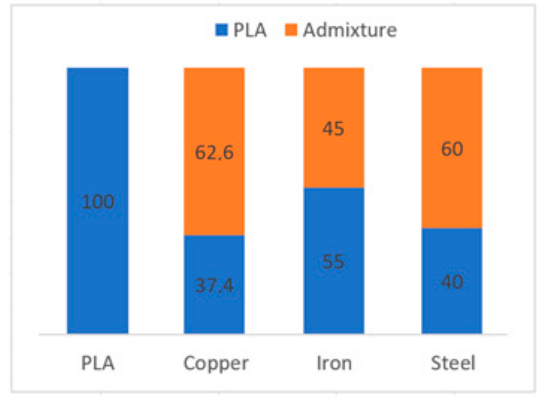
Figure 4. Proportion of admixtures in PLA material in percentage by weight.